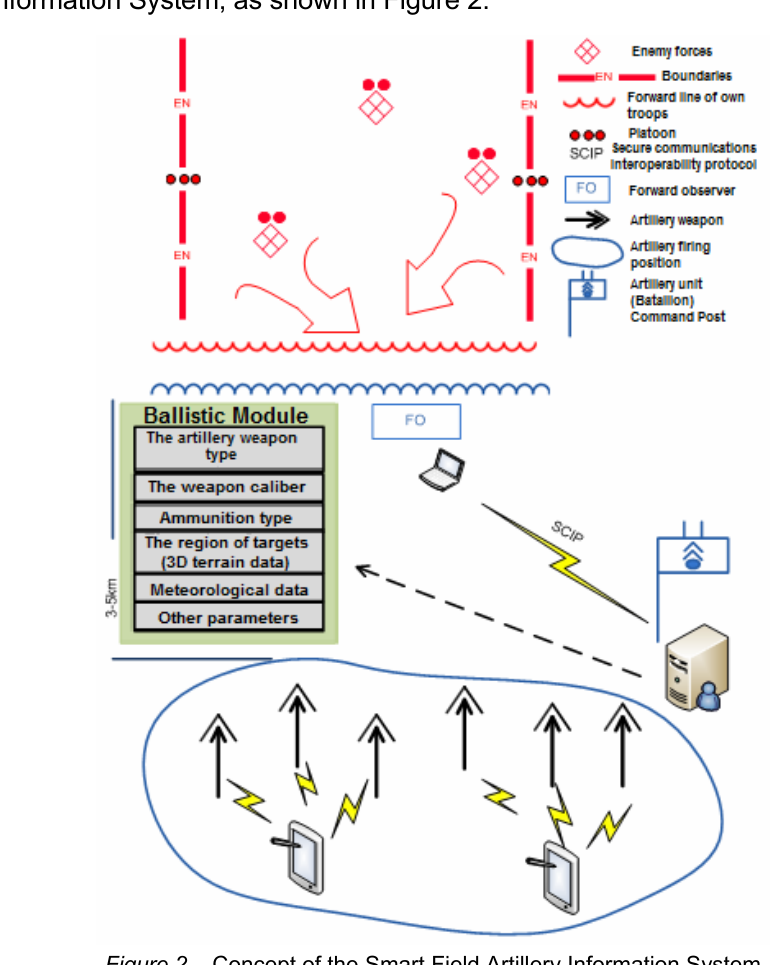
Figure 2 – Concept of the Smart Field Artillery Information System Рис . 2 – Концепт интеллектуальной информационной системы полевой артиллерии Слика 2 – Концепт паметног информационог система пољске